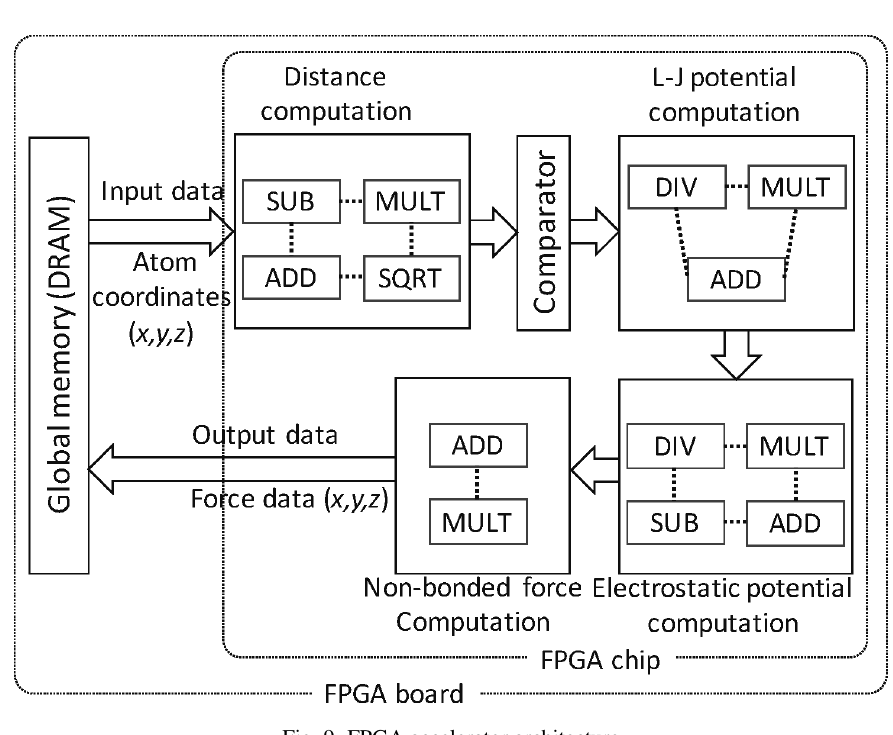
Fig. 9. FPGA accelerator architecture.